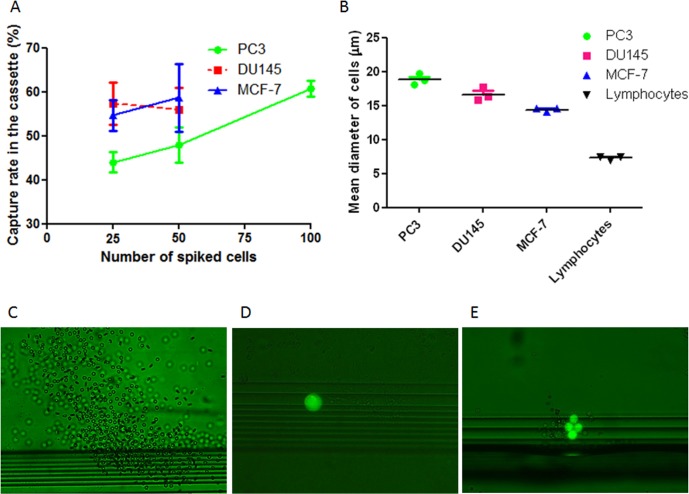
Spiked cancer cell lines test for capture rates.(A) Mean capture rate for spiked PC3, DU145 and MCF-7 after isolation. (B) Three repeated measurements for the mean diameter of PC3, DU145, MCF-7 and normal human lymphocytes. (C-E) representative examples of (C) smaller lymphocytes in the process of passing through the gap and exiting Parsortix cassette to the waste, magnification 100X); (D) captured pre-labeled single spiked cell in the stepped gap, magnification 200X; and (E) captured pre-labeled cluster of spiked cells in the stepped gap, magnification 200X.